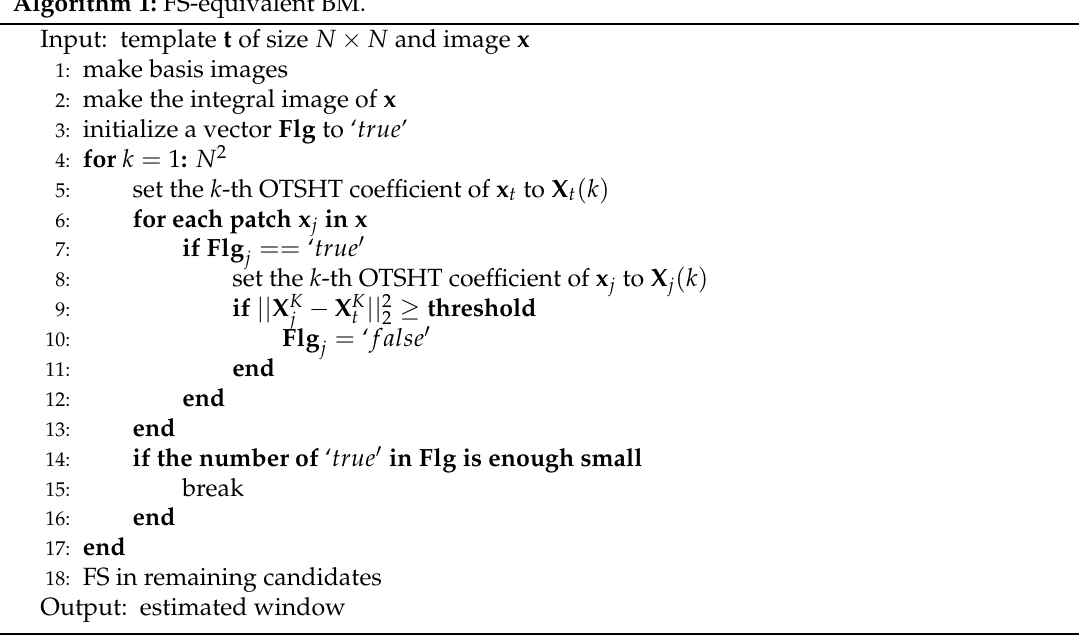
Algorithm 1: FS-equivalent BM.